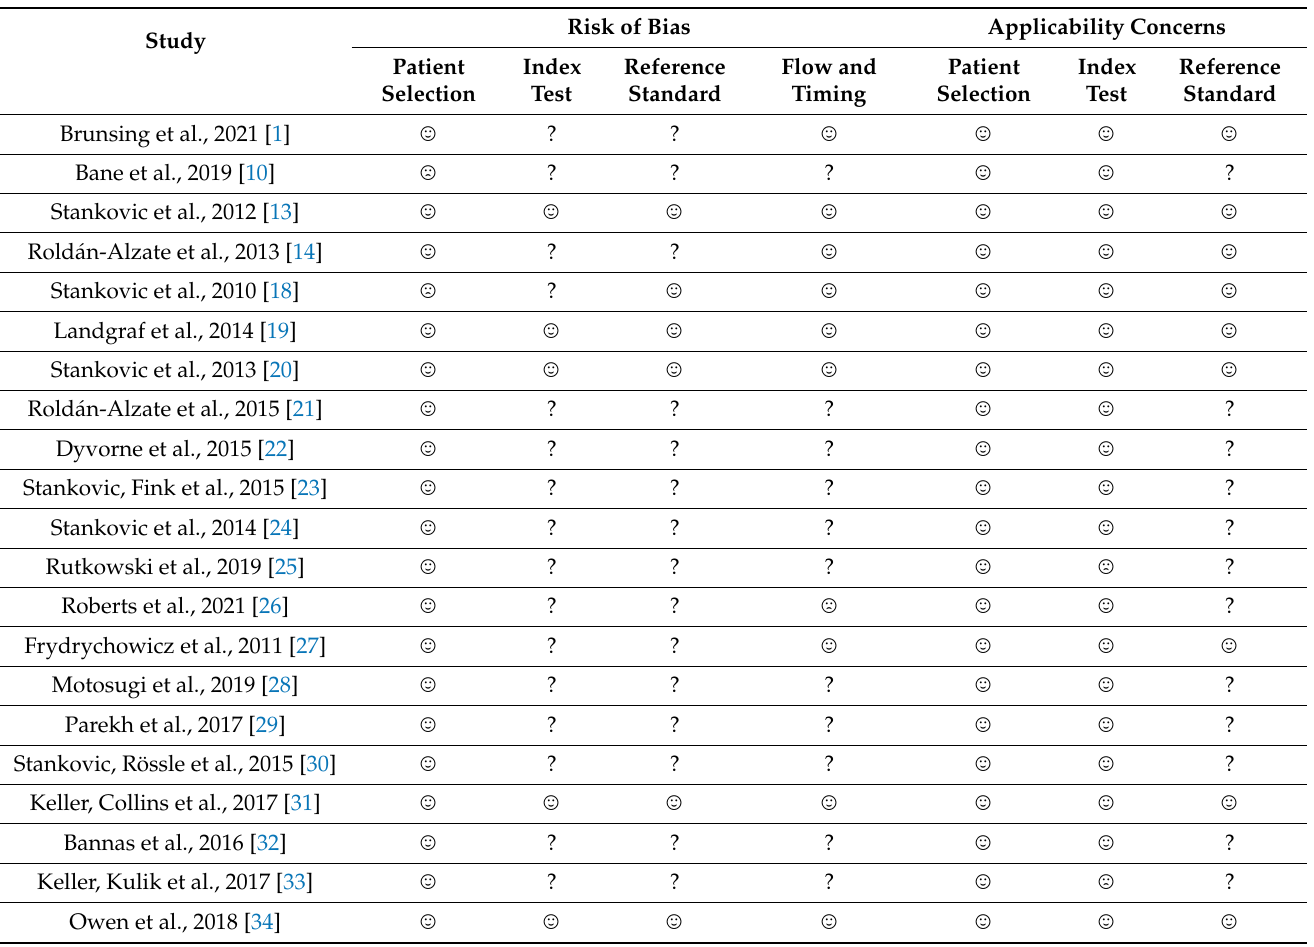
Table 3. Results from the QUADAS-2 examination of included studies. Risk of bias and concerns regarding applicability of the included studies: Low Risk; High Risk; ? Unclear (cid:44)